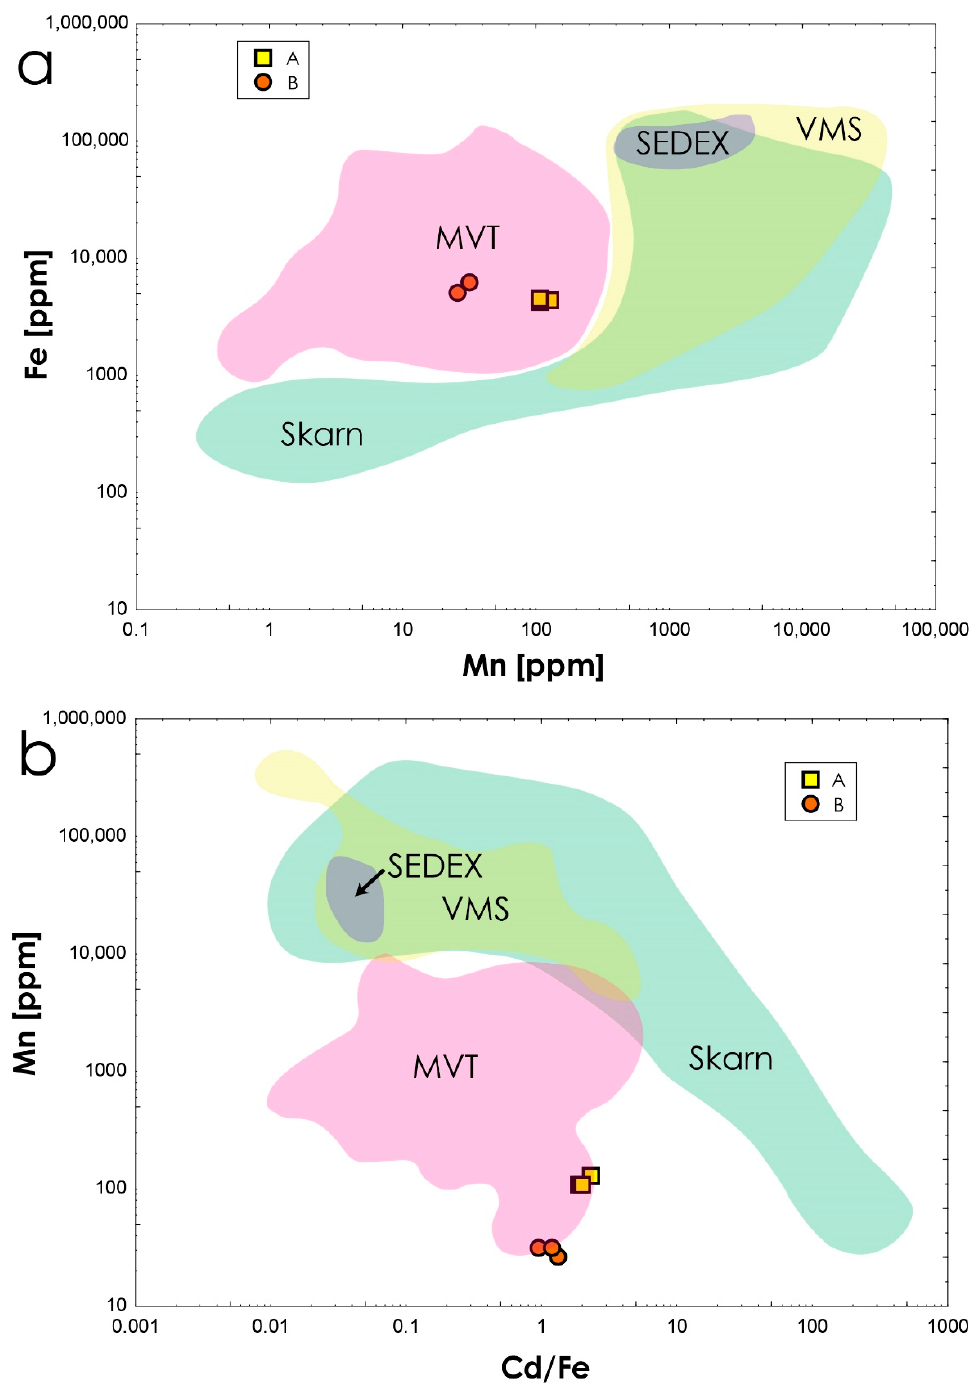
Figure 6. Plots of ( a ) Mn vs. Fe and ( b ) Cd/Fe vs. Mn in studied sphalerite samples based on the LA-ICP-MS data. Fields for selected genetic types are from [28].